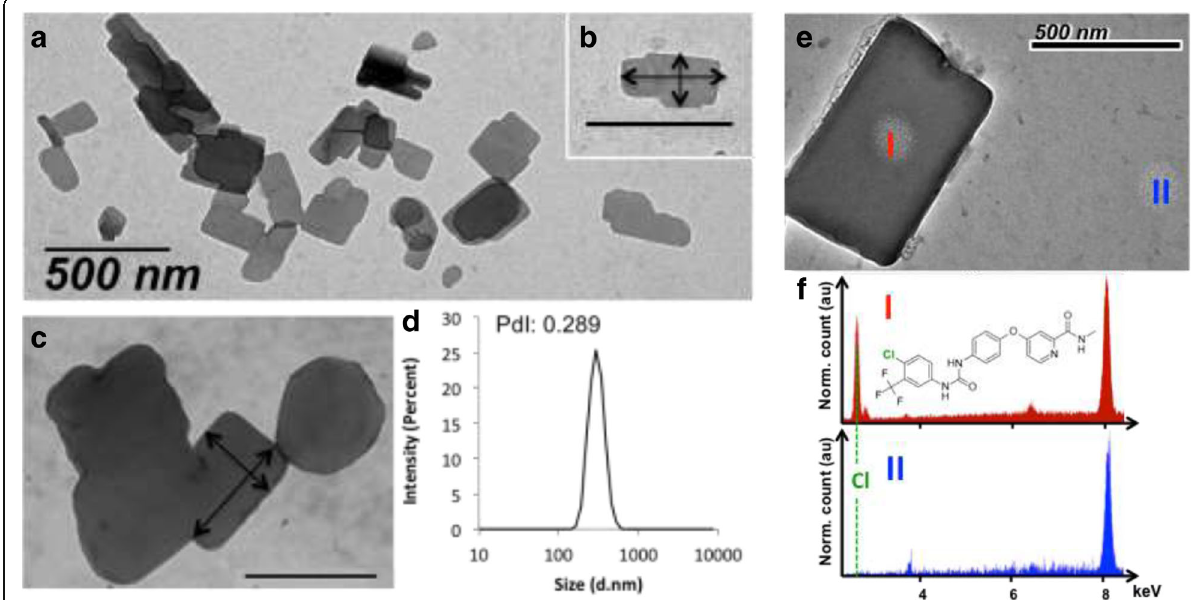
Fig. 2 SLNs characterization. Transmission electron microscopy (TEM) images showing the morphology of sorafenib nanoparticles with DOTAU ( a ) and inset ( b ). Example of a DOTAU-based SLN featuring a size of 327 by 172 nm (arrows), which confirm an average size of 304 nm as measured by DLS ( d ). c Example of TEM image showing diC 16 dT-SLNs (arrows 330 by 500 nm, respectively). ( e ) TEM image of a SLN-. I & II spots are the localisations where EDX acquisitions was performed. ( f ) EDX spectra at I & II positions. Dashed line emphasized the emission of chlorine atom, which is only present in I. Chemical structure of Sorafenib molecule is also presented. Both spectra were normalized with Cu atom emission at 8 keV (due to TEM Cu